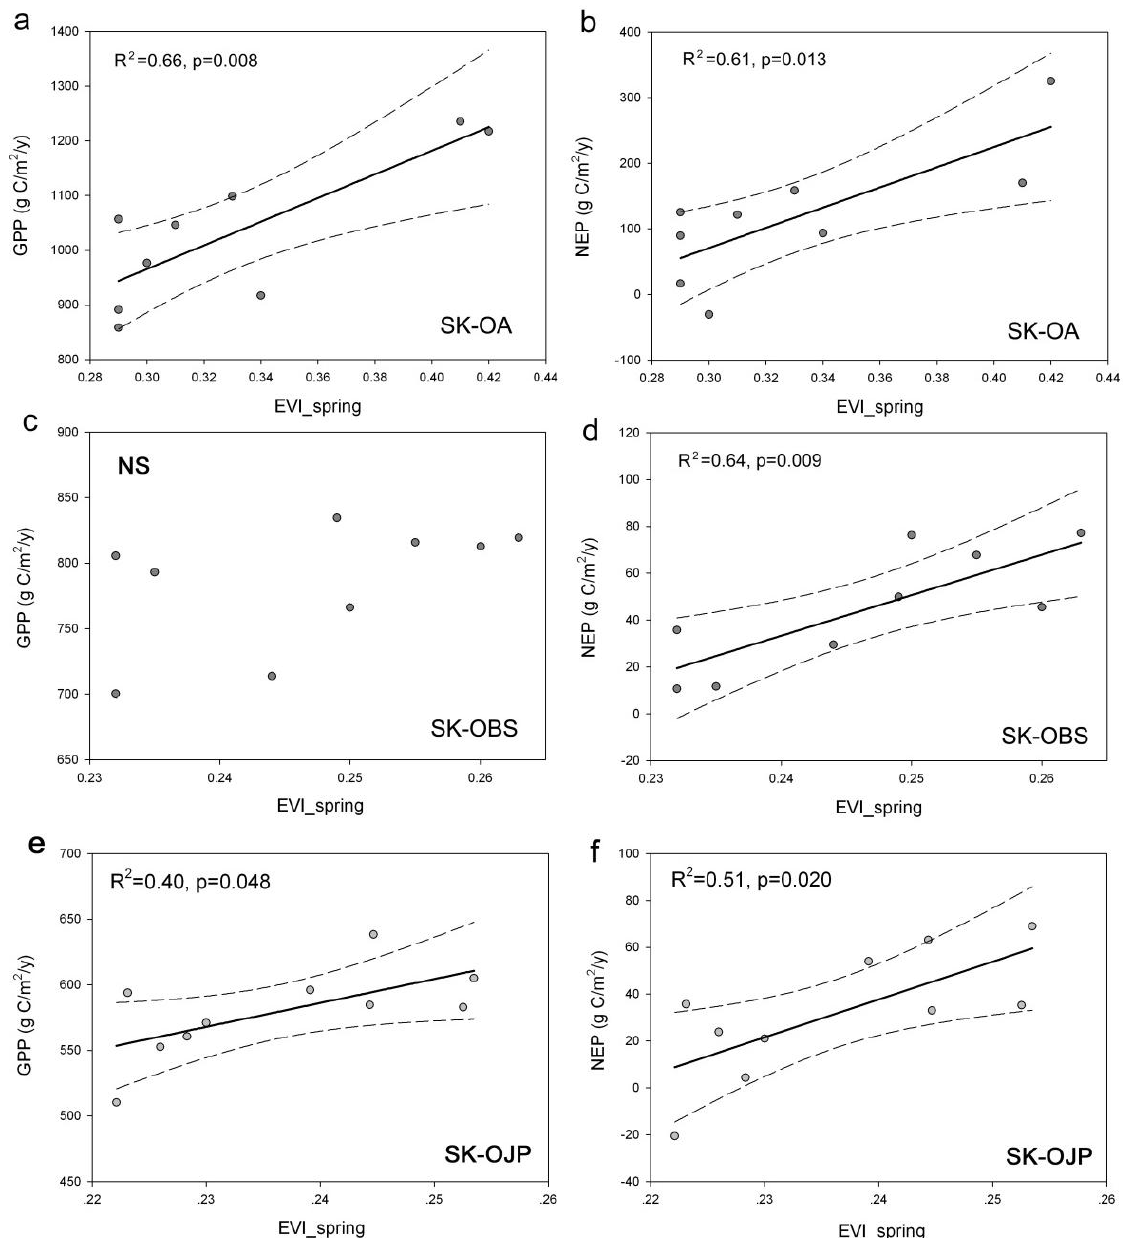
Figure 6. Relationships among spring enhanced vegetation index (EVI) and ( a ) GPP of SK-OA, ( b ) NEP of SK-OA, ( c ) GPP of SK-OBS, ( d ) NEP of SK-OBS, ( e ) GPP of SK-OJP, and ( f ) NEP of SK-OJP. NS indicates no significant correlation. The solid and dashed lines represent regression and its 95% confidence of mean